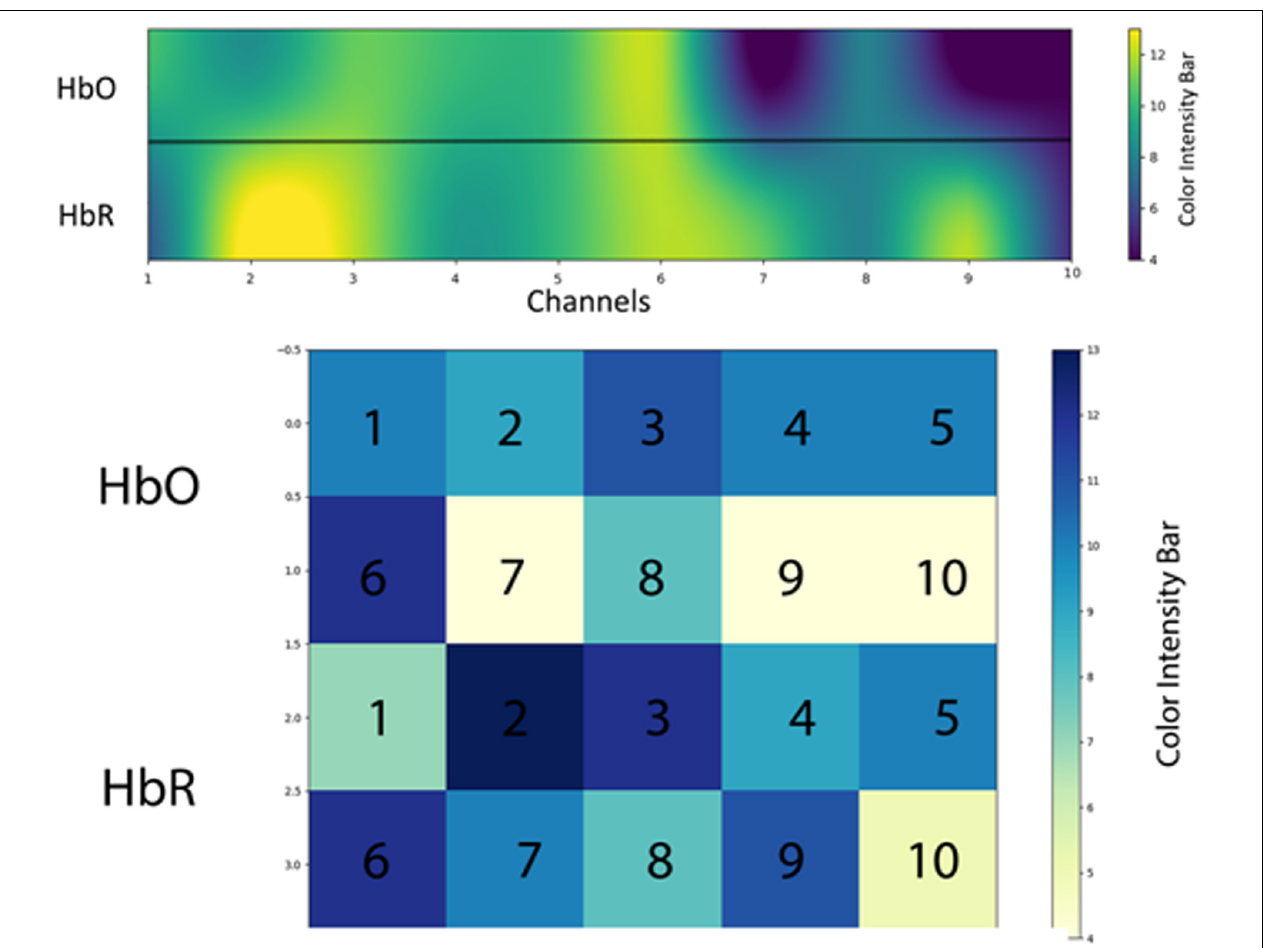
FIGURE 11 | The regions of interest (ROIs) using oxyhemoglobin (HbO) and deoxyhemoglobin (HbR)—response for a specific activity compared with the other areas in prefrontal cortex (PFC). Activation map averaged over all 15 subjects (only significant channels are considered) during activation.